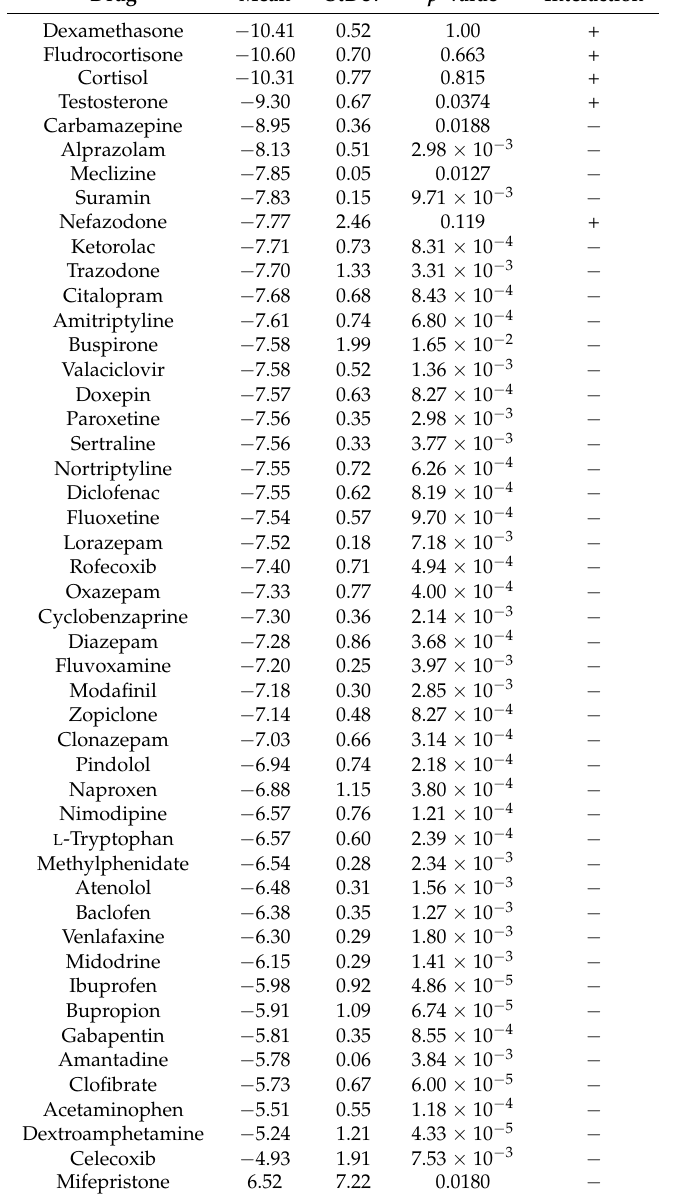
Table 4. Interaction of common drugs used to treat GWI symptoms with the GCR agonist form. Mean binding energy and standard deviation are in units of kcal/mol. A t -test was used to compare to the known binder dexamethasone. (+) indicates putative binding, ( − ) indicates no putative